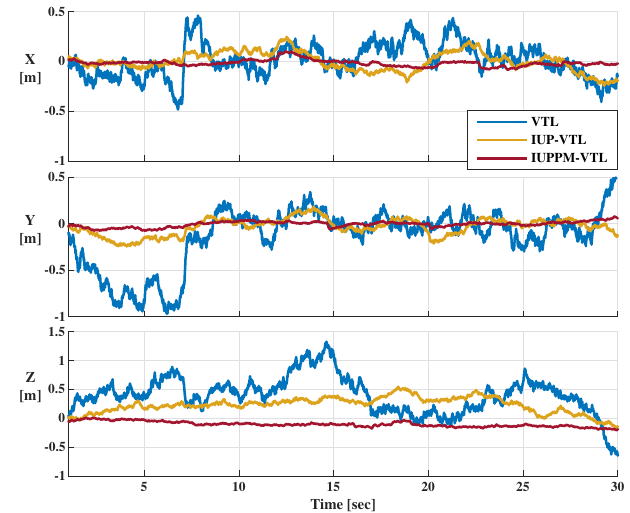
Figure 12. Position errors of three VTL structures in XYZ